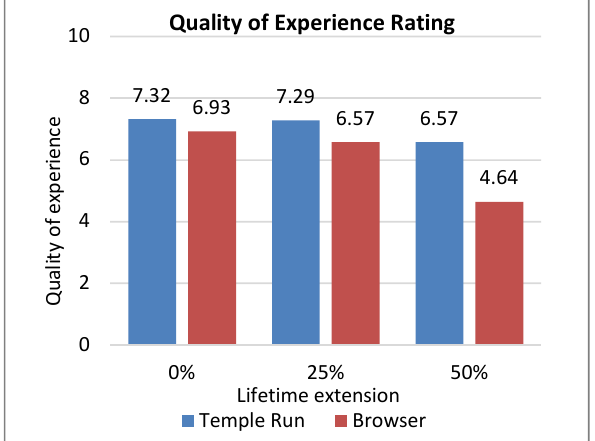
Figure 6. Quality of experience Rating